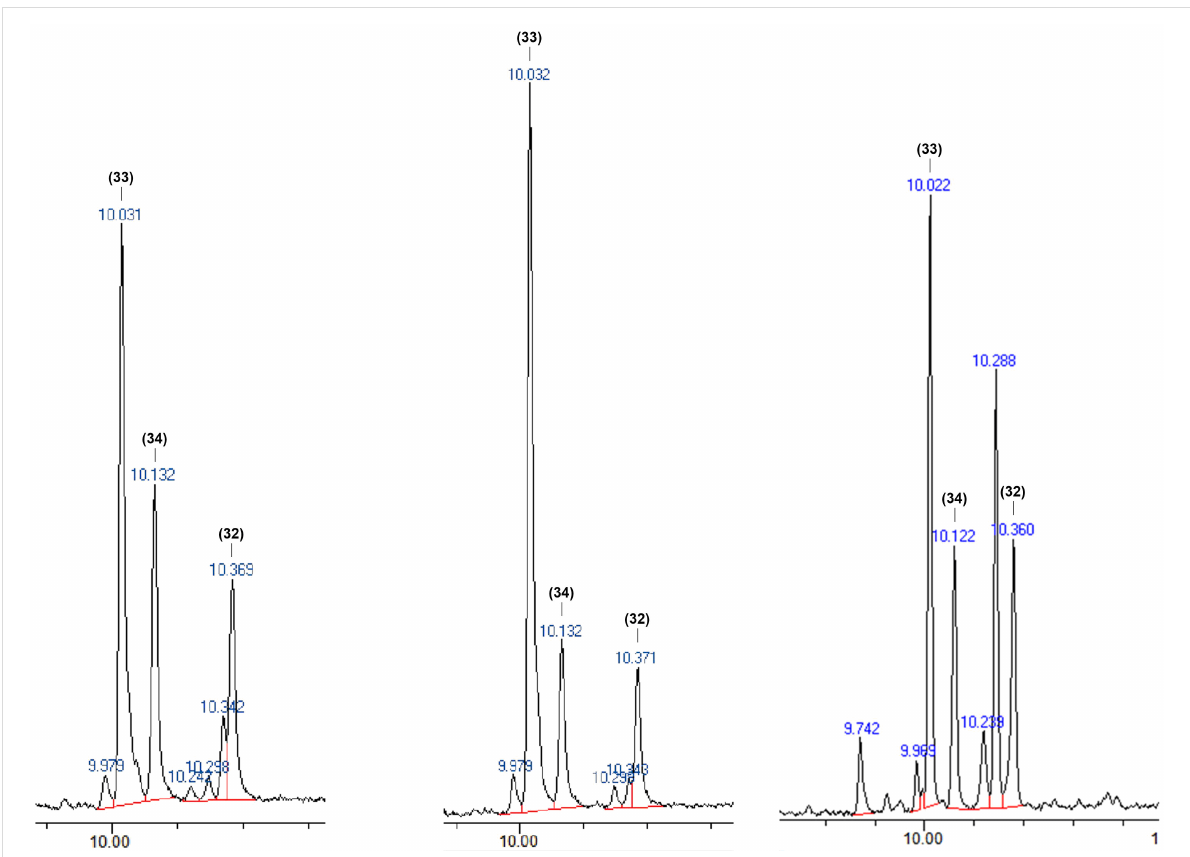
Figure 4: Iso E Super ® region of GC spectra of Molecule 01 (left, 75 €–100 € per 100 mL; march 2019), a low-priced counterpart from TOP2BASE (middle, 20 € per 100 mL) and product produced in our laboratories under flow conditions. Note, although both samples provide a similar smell, the olfactory effects slightly vary because of different proportions of products and isomers produced in very small amounts that impact the nuances of a scent significantly (GC analyses were conducted in the author´s laboratories on a Zebron™ phenomenex ZB-1MS F&F (20 m, 0.18 mm, 0.18 µm)